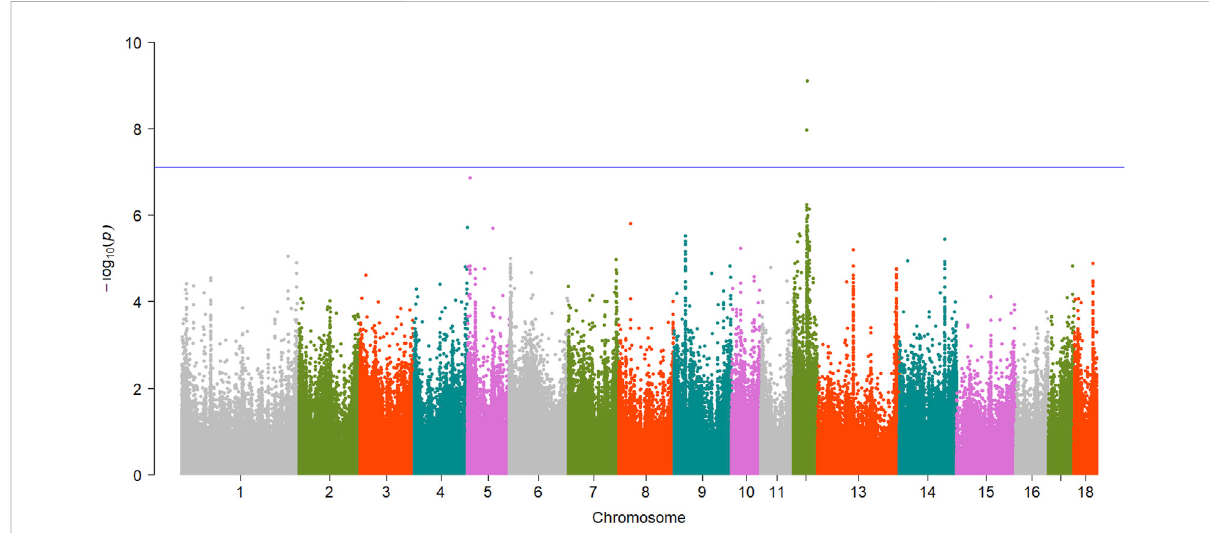
FIGURE 3 Manhattan plot showing EWAS results for b* trait. Each dot represents an CpG site and the blue line represents the threshold.